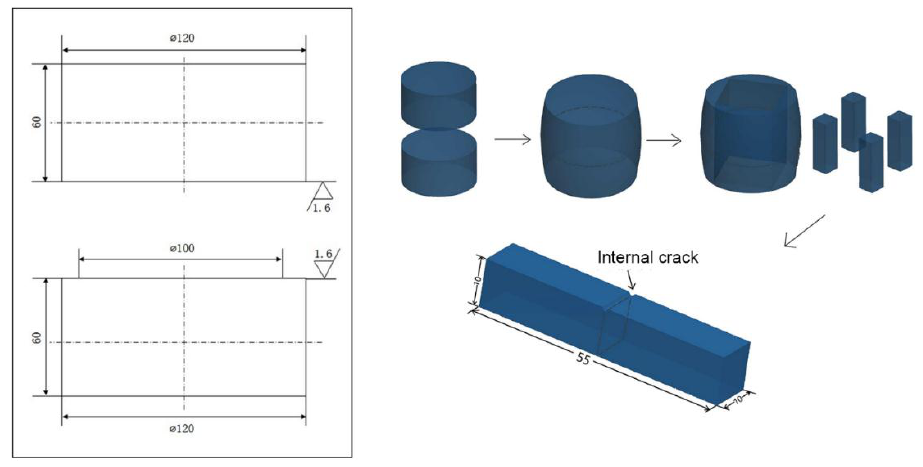
Figure 1. A schematic illustration of the butt-joint method.